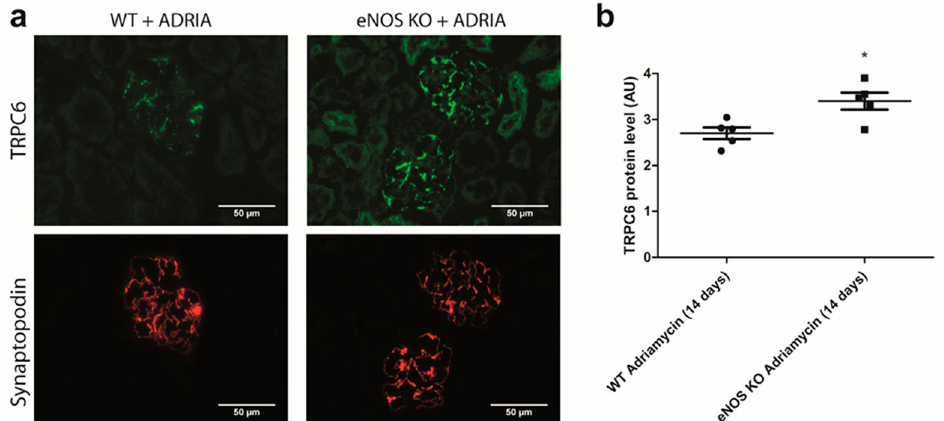
Figure 8. In mice, eNOS knockout enhances glomerular TRPC6 expression upon Adriamycin-induced nephropathy. Adriamycin nephropathy was induced in C57Bl/6J WT and eNOS KO mice, and mice were sacrificed after 2 weeks. ( a ) Representative pictures of the glomerular TRPC6 and synaptopodin expression in WT and eNOS KO mice. ( b ) Glomerular TRPC6 expression was determined via semi-quantitative analysis of immunofluorescent signal by scoring 25–30 glomeruli per animal on blinded sections performed independently by two investigators. N = 5 per group. * p < 0.05.